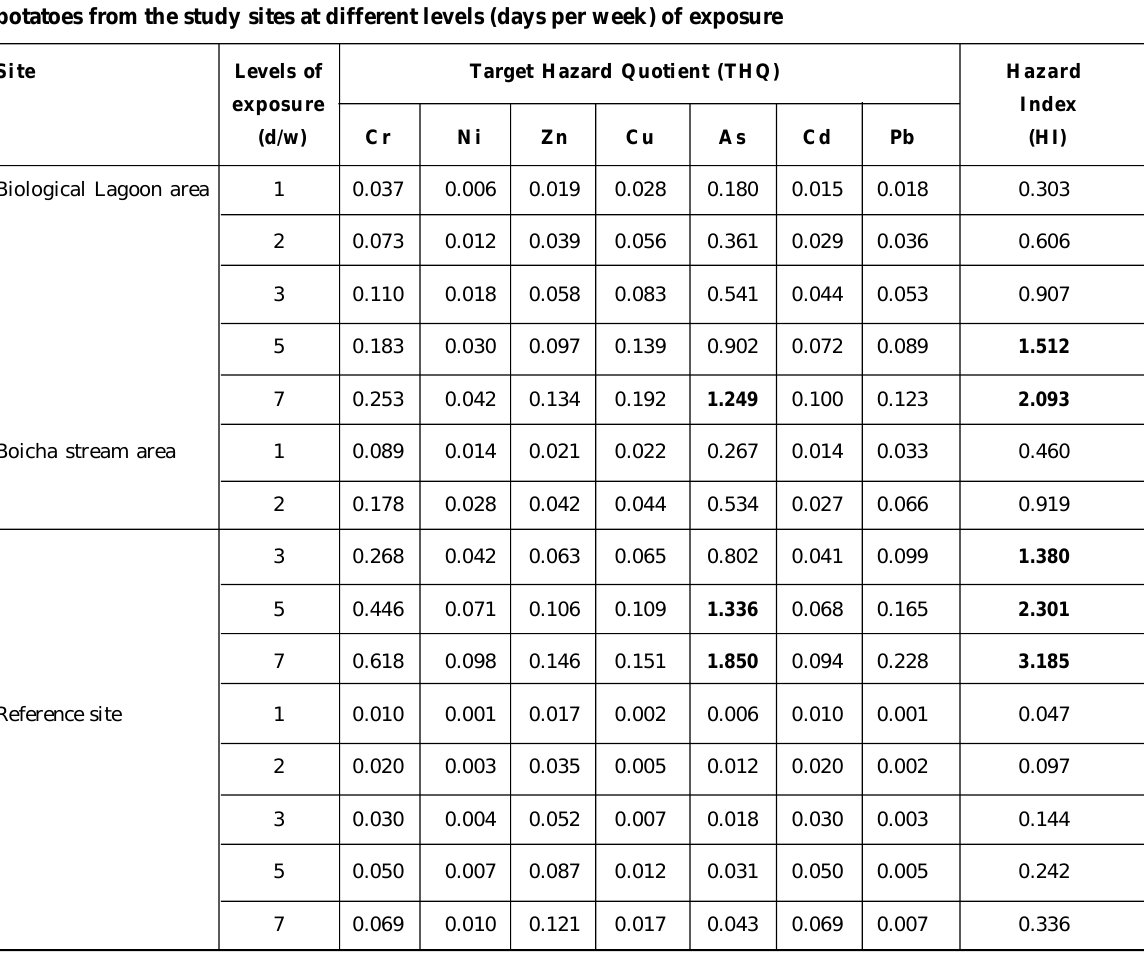
Table 3: Target Hazard Quotient (THQ) and Hazard Index (HI) of heavy metals from consumption of potatoes from the study sites at different levels (days per week) of exposure